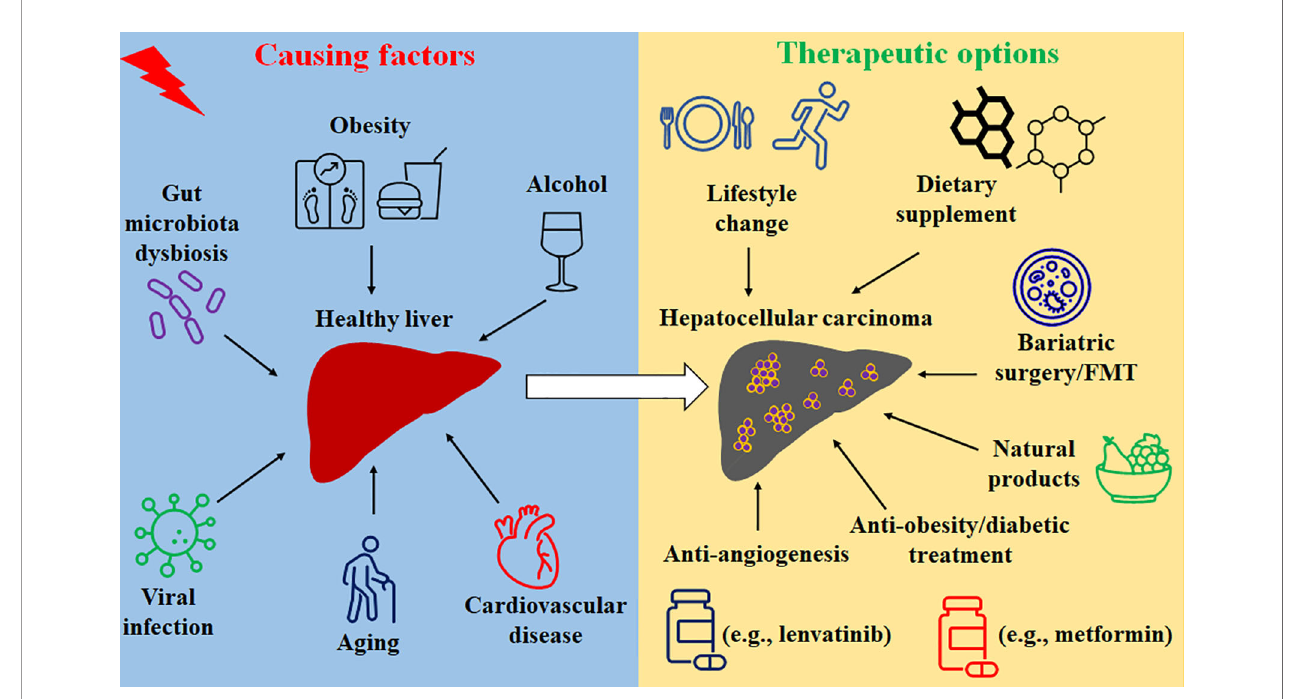
FIGURE 1 | The causing factors and treatment options of